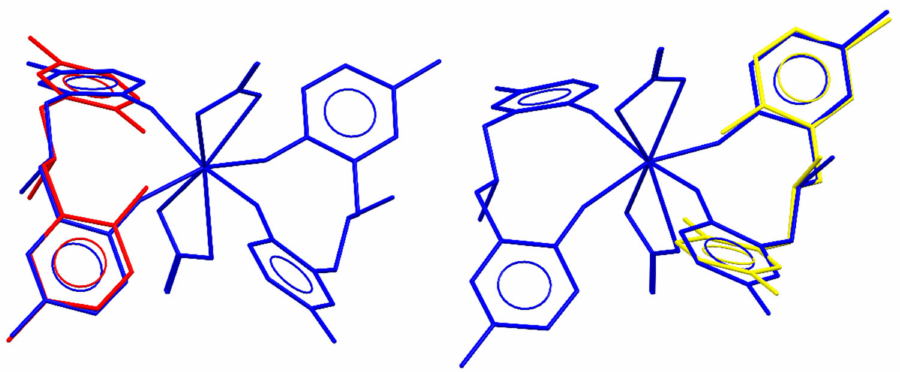
Figure 2. Molecular overlay diagrams of the Ce-MMD complex (blue structures) and the MMD ligand (IDUHEV from ref. [38] shown in red and yellow structures). Twenty non-hydrogen atoms of the cerium-MMD complex, namely C1–C17/N1/O1–O2, are overlayed to the same atoms in the MMD ligand (red structure) with the r.m.s. deviation of 0.394 Å. Twenty non-hydrogen atoms of the Ce-MMD complex, namely C18–C34/N2/O3–O4, are overlayed to the same atoms in the MMD ligand (yellow structure) with an r.m.s. deviation of 0.397